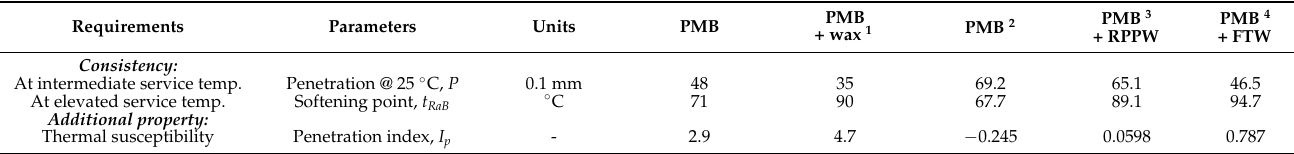
Table 4. Consistency and thermal susceptibility of different